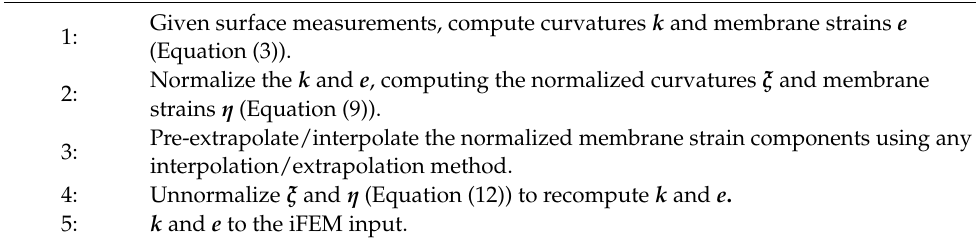
Algorithm 1 : Variable Thickness